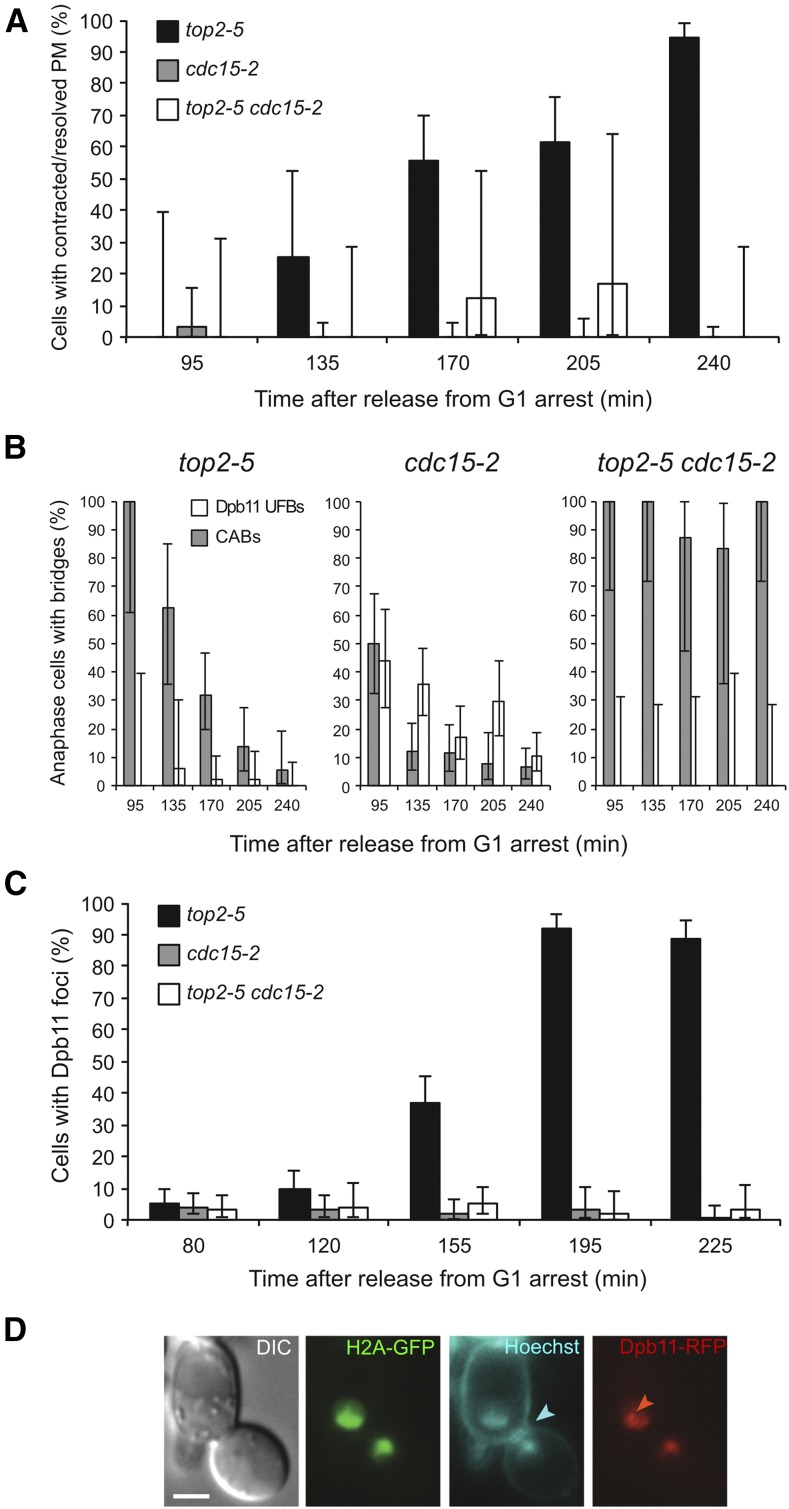
Dpb11 Ultrafine bridges are also destabilized by cytokinesis in top2-5. Coisogenic top2-5, cdc15-2, and top2-5 cdc15-2 strains bearing the HTA2-GFP Dpb11-yEmRFP bar1∆ genotype were released into a synchronous cell cycle at 37°. At the indicated time points, the plasma membrane (PM) was stained with 5 µg/ml Hoechst 33258 for 5 min at 37° before processing for fluorescence microscopy. (A) The time course of PM abscission (full contraction and resolution at the cytokinetic plane). Note how top2-5 mutant cells progress to abscission. (B) The time course of both CABs and UFBs in anaphase cells. Note how top2-5 mutant cells do not accumulate UFBs, not even transiently, while CABs are split apart. (C) The time course of Dpb11 foci formation. Note how top2-5 mutant cells accumulate Dpb11 foci. Error bars depict CI95 (n = 50–200). (D) The prototypical example of a late anaphase top2-5 cell; i.e., PM has completed abscission, there is no longer a CAB connecting the mother and the daughter cell, nor are there any Dpb11-UFBs, and Dpb11 accumulates in foci within the split nuclear masses instead. The cyan arrowhead points to the resolved PM, whereas the red arrowhead points to a Dpb11 focus. The bar corresponds to 3 μm. DIC, differential interference contrast.